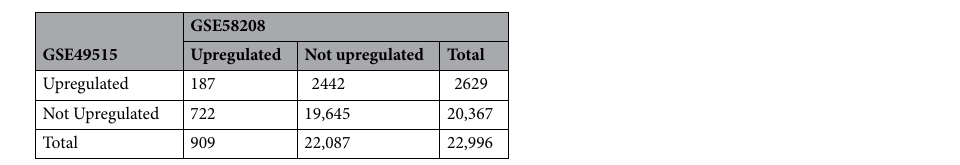
Table 1. Results from the bioinformatics approach (CU-DREAM program) demonstrated the 187 upregulated genes ( p -value = 9.91 × 10 −19 , Odd ratio = 2.08, upper 95%CI = 2.46 and lower 95%CI = 1.76) from